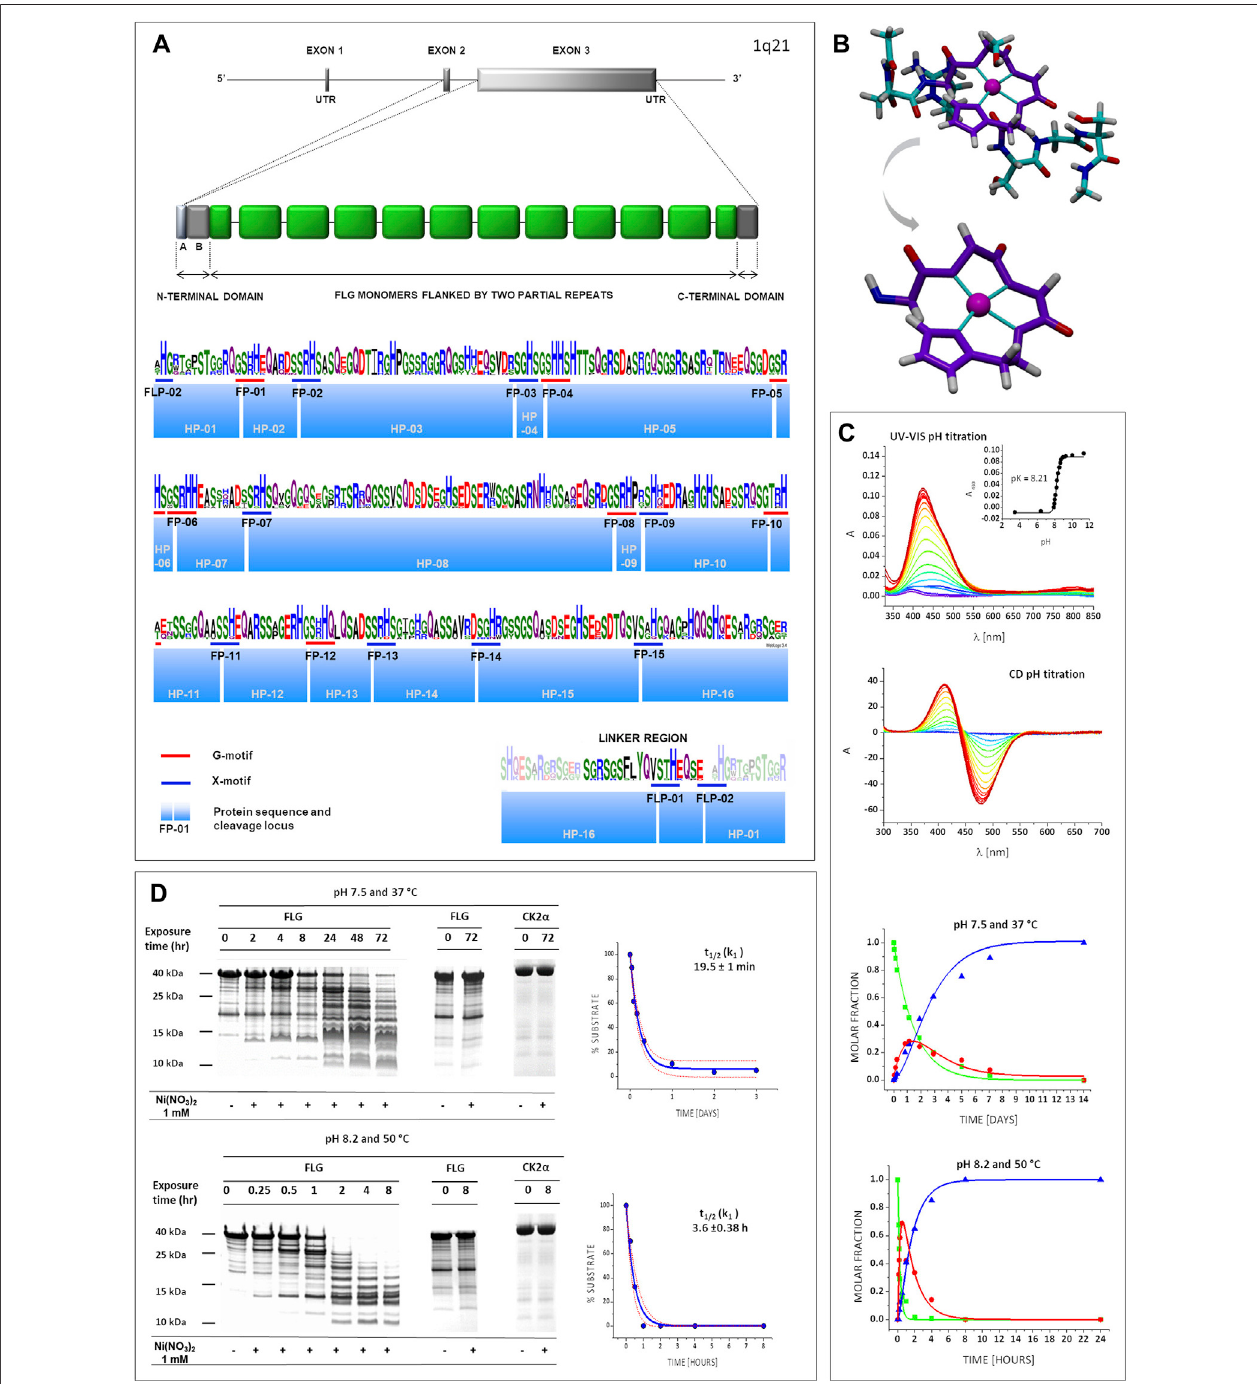
FIGURE 2 | FLG structure and susceptibility to Ni-hydrolysis. (A) The FLG gene, located on chromosome 1q21, consists of three exons and two introns. ProFLG protein contains several nearly identical FLG monomer units (green) fl anked by partial monomer repeats and the N- and a C-terminal domains (dark grey). Each FLG monomerunitisseparatedfromtheotherrepeatsbyalinkerregionthatisproteolyticallycleavedduringprocessingofproFLGintomonomers[adaptedfromSandilands et al. (2009)]. A graphical representation of an amino acid multiple sequence alignment is shown; the height of a stack indicates the sequence conservation, while theheightofsymbolswithinthestackindicatestherelativefrequencyofeach aminoacidat thatposition.Coloursofaminoacidsaccordingtochemicalproperties:polar (green), neutral (purple), basic (blue), acidic (red), hydrophobic (black). Blue and red bars symbolize Ni-hydrolytic motifs; blue boxes symbolize oligopeptides, predicted productsofNi-hydrolysis(HPs).FPs(FLGpeptides) andFLP(FLGlinkerpeptide)meansconsecutivecleavagemotifswithintheFLGsequence. (B) Molecular modelofa representativecomplex(Ni-FP-05).Atomsaremarkedas:cyan(C),red(O),white(H),indigo(N)andmagenta(Ni).4Nsquareplanarstructure ishighlightedinpurple. (C)